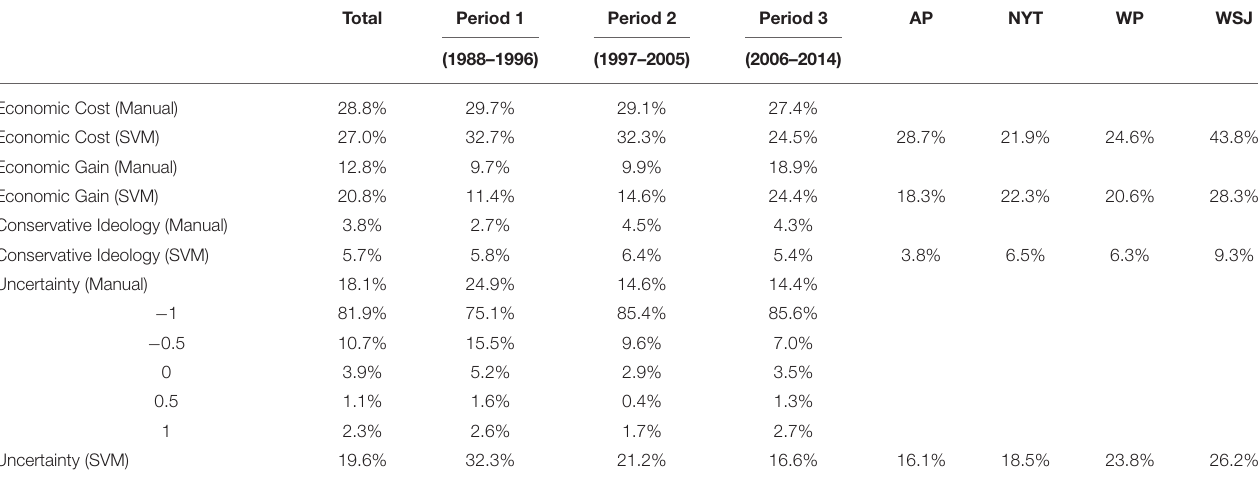
TABLE 2 | Hand coding and SVM